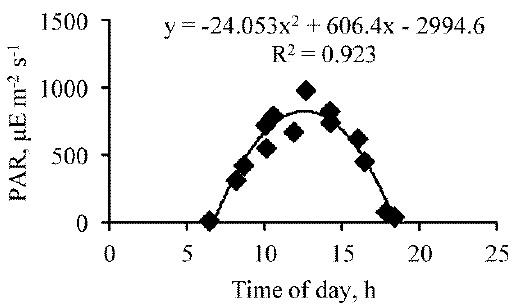
Figure 2. Diurnal course of photosynthetically active radiation (PAR) in the upper layer of the water column in Lake Moynaki during 15–16 September 2021. The ascending axis of the bell, from 6:00 to about 13:00, can be described by the equa- tion (R = 0.911, p = 0.001):